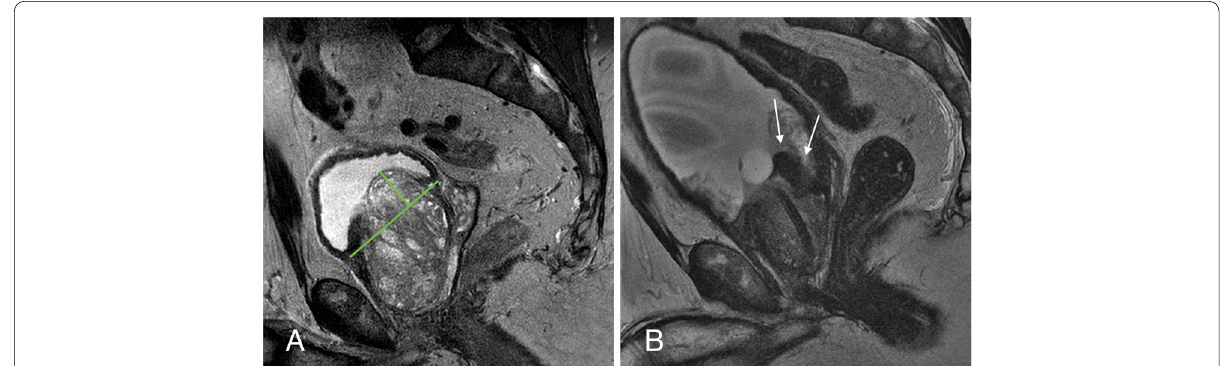
Fig. 1 A Pre PAE T2-weighted MRI in sagittal view showing a very enlarged prostate, with a large medium lobe (grade III IPP embolization, marked hypointense signal and volumetric reduction of the medium lobe was observed (arrows). (*) Foley balloon. A cystoscopy confirmed the presence of a necrotic medium lobe leading to ball-valve